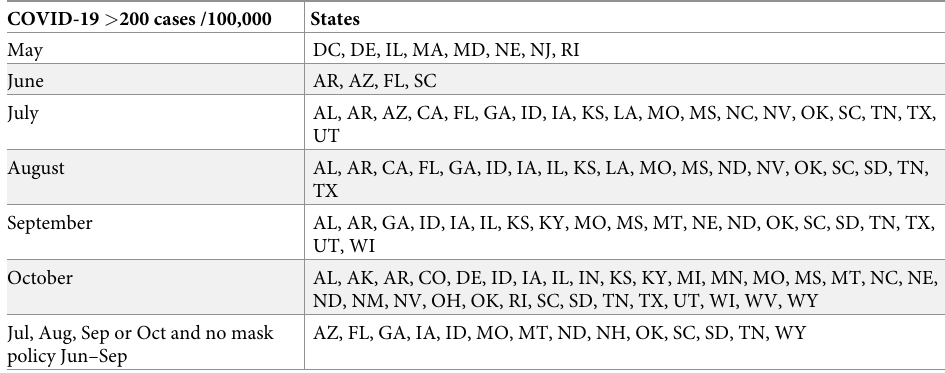
Table 2. States with high COVID-19 rates.